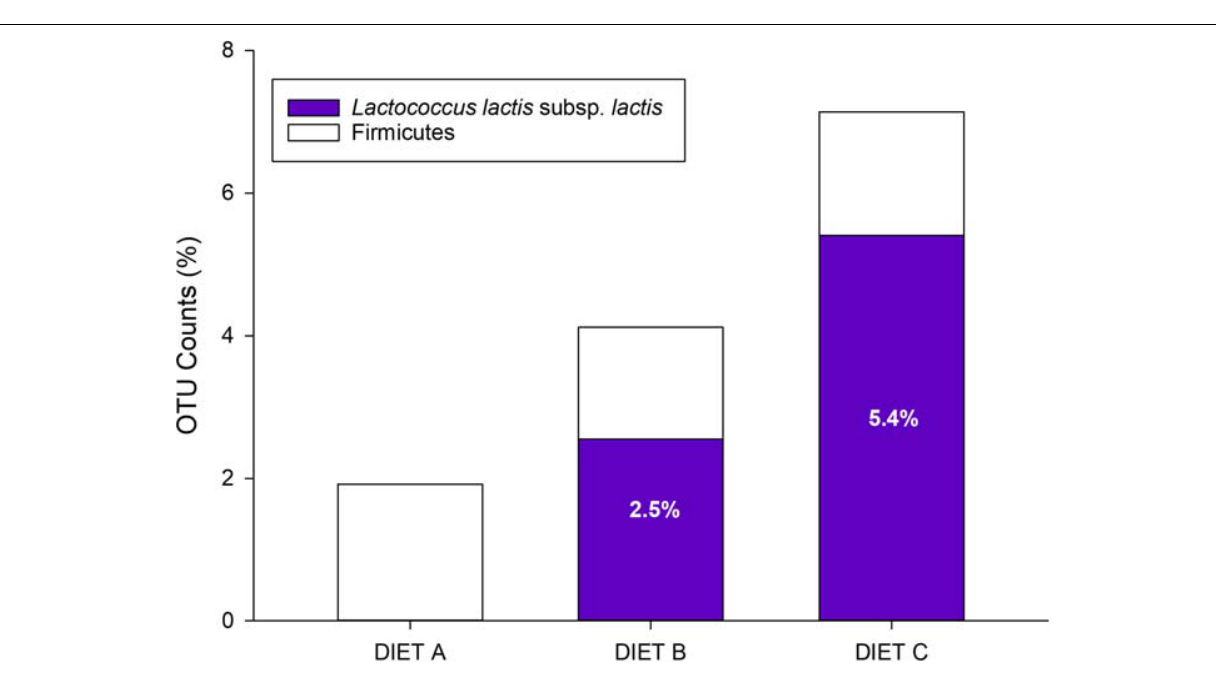
reads were assigned to 1,313 OTUs at 97% identity